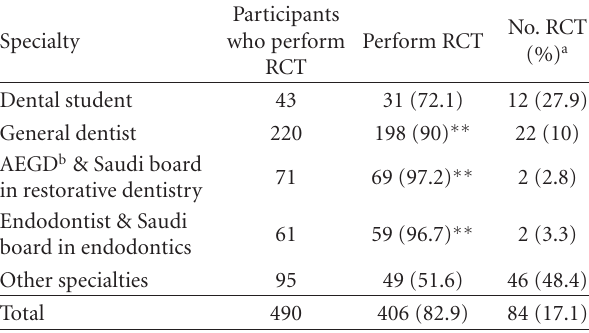
Table 1: Root canal performance according to